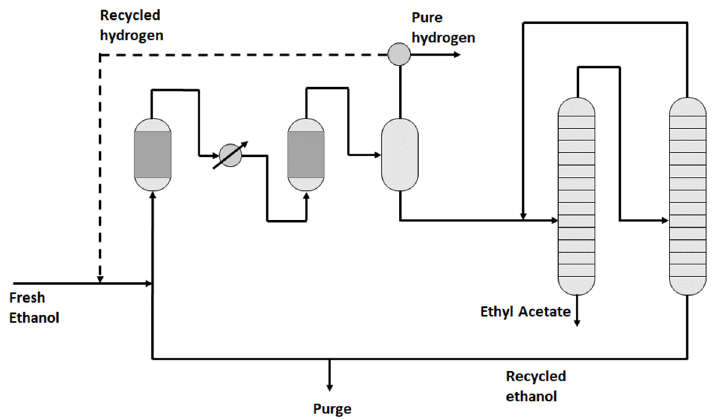
Figure 6. Simplified scheme of the Eurochem process for ethanol dehydrogenation. Employed catalyst CuCrO 4 /CuO/Cu/BaCrO 4 /Al 2 O 3 [42].